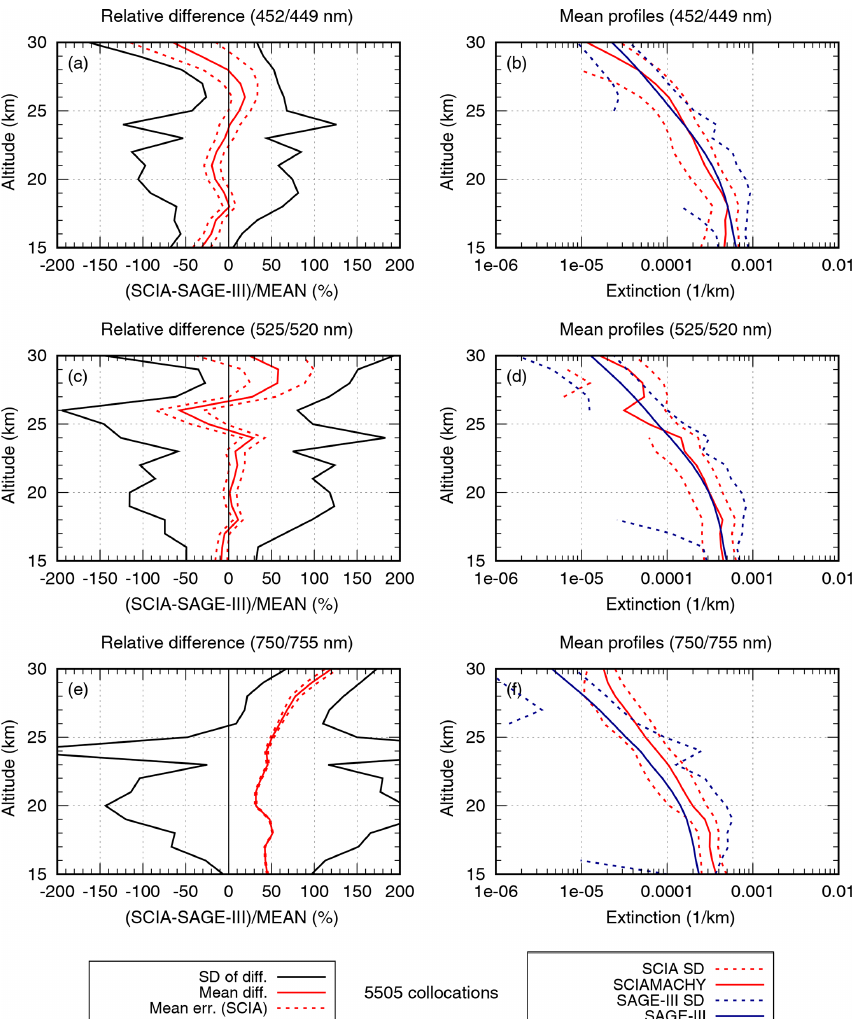
Figure 10. As Fig. 9 but for comparison with SAGE-III aerosol extinctions at 452 / 449, 525 / 520 and 750 / 755nm (first wavelength is for SCIAMACHY, second for